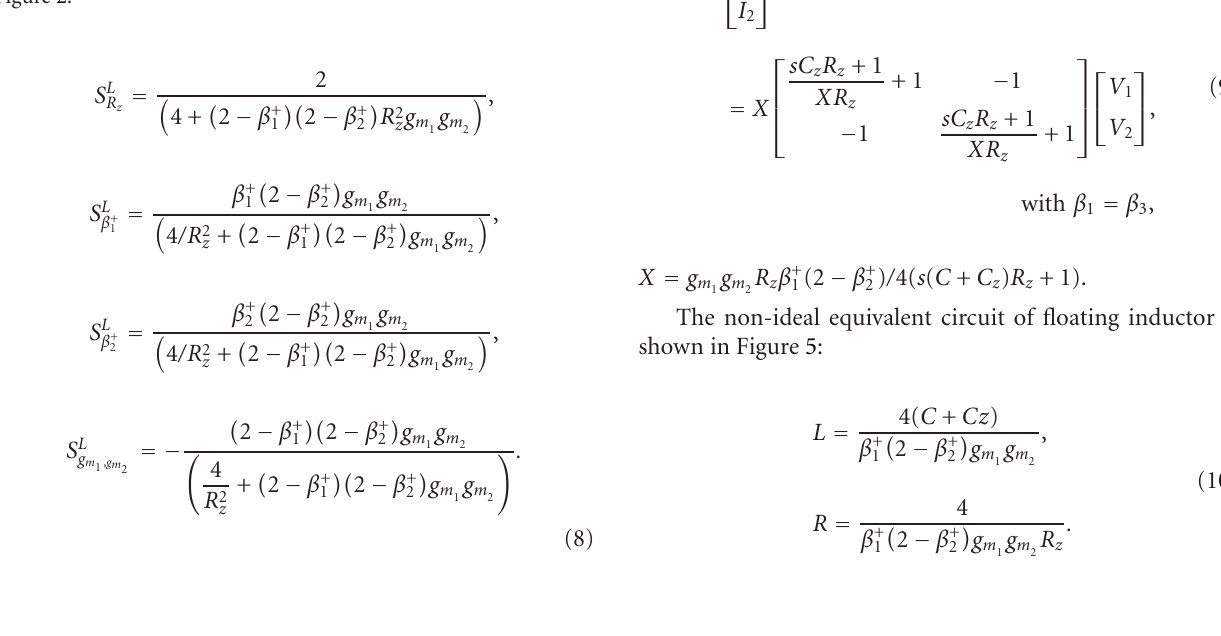
Figure 4: Non-ideal equivalent circuit of grounded inductor of Figure 2.